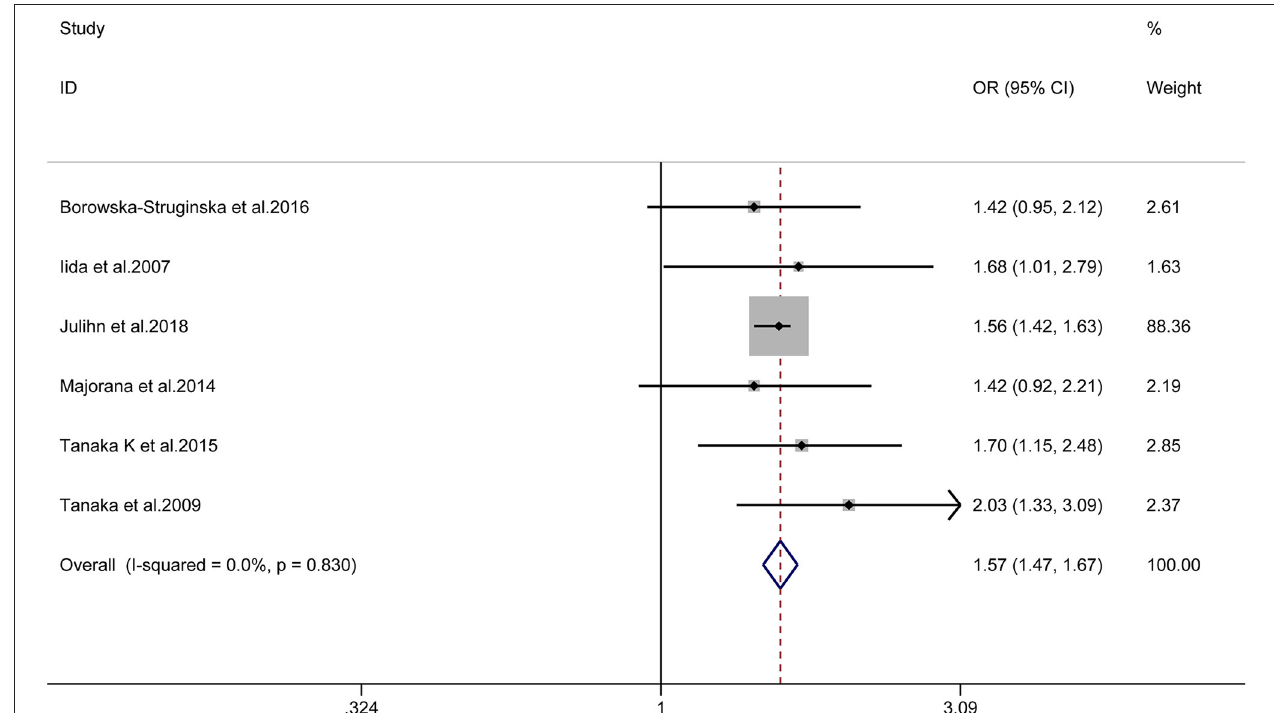
FIGURE 2 | Forest plot of maternal smoking during pregnancy and childhood caries (cross-sectional studies).